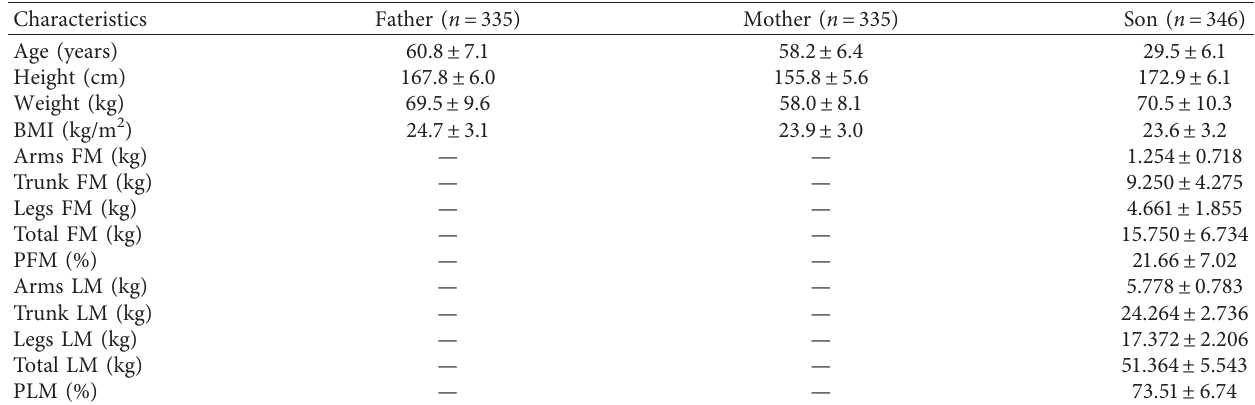
Table 2: Basic characteristics of the subjects (mean ±